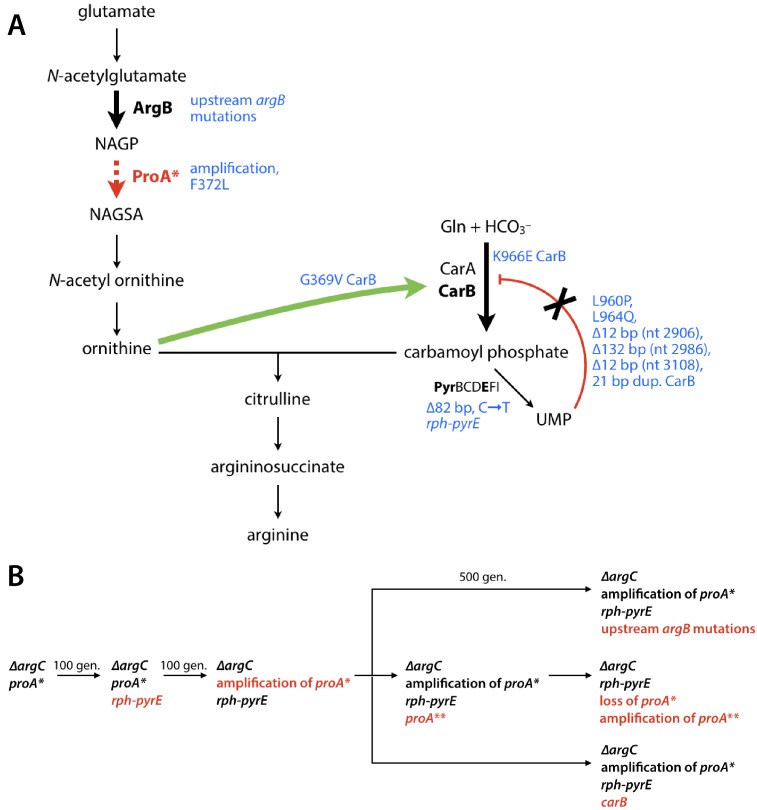
Adaptive mutations are predicted to increase flux through the arginine synthesis pathway.(A) The pathway bottleneck enzyme ProA* is shown in red. Steps in the arginine synthesis pathway that are affected by adaptive mutations (blue) are highlighted by bold arrows. (B) Trajectories for adaptive mutations observed during 470–1000 generations of evolution. Red text denotes a new mutation.